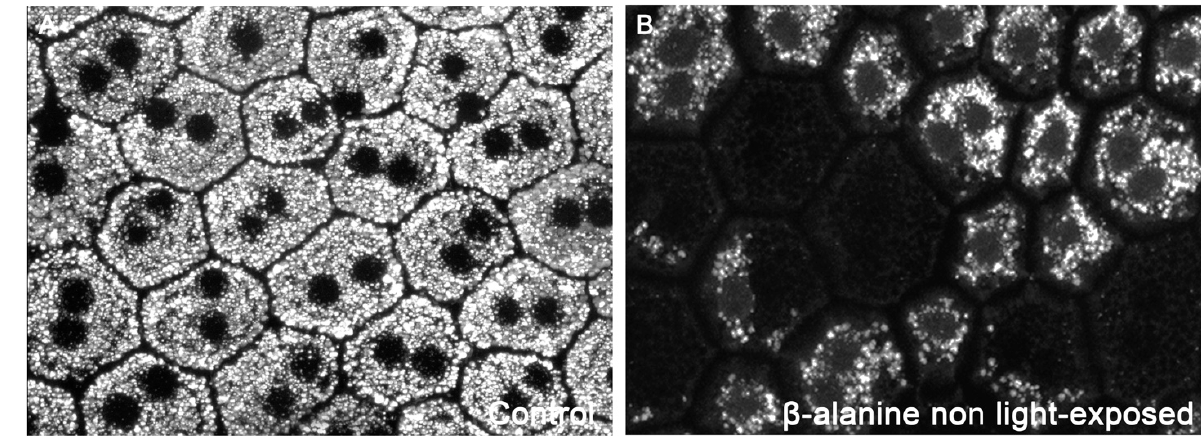
Figure 7. Photomicrographs showing the morphology of the retinal pigment epithelium in control ( A ) and taurine depleted ( B ) rats acquired with confocal microscopy. In taurine depleted animals some retinal pigment epithelial cells show less or do not show FG accumulations within the cyto- plasm.